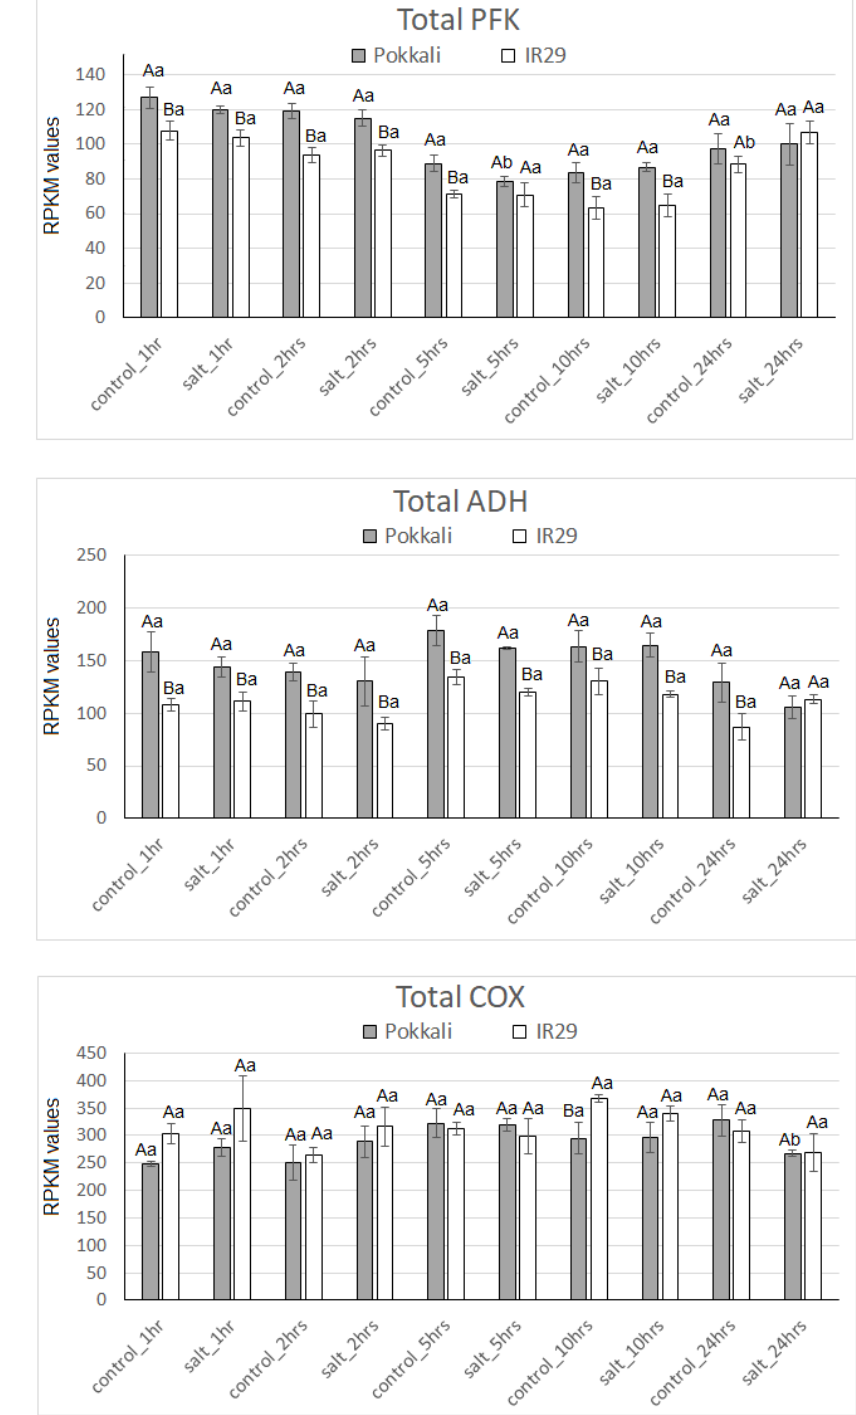
Figure 1. Expression profiles of Total PFK ( A ), ADH ( B ) and COX ( C ) genes in Pokkali and IR29 genotypes of Oryza sativa under salt stress. Data represent RPKM means with standard deviations from 3 biological replicates. For each gene, different capital letters indicate significant differences (at p < 0.05) between genotypes (Pokkali and IR29), while lowercase letters designate significant differences between treatments (control and stress) at the same time point and genotype, according to Bonferroni’s